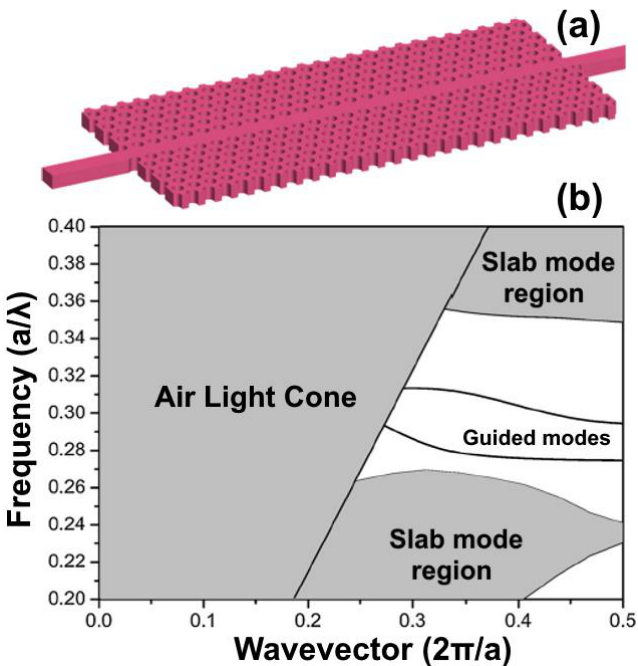
Figure 15. ( a ) Photonic crystal waveguide slab; ( b ) photonic band diagram